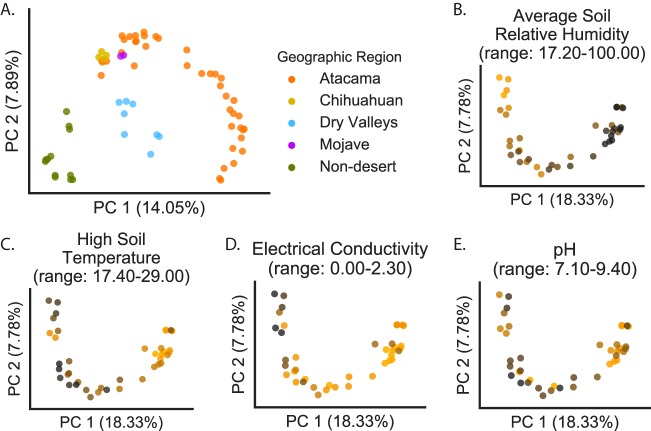
Unweighted UniFrac PCoA plots. (A) Combined data from the present Atacama Desert study and from Fierer et al. (19). (B to E) Atacama-only data. (A) Samples colored by their geographic origins. (B to F) Samples colored by soil properties, where light colors indicate the low end of the specified range and dark colors indicate the high end of the specified range. These data illustrate statistical results presented in Table S3, specifically, that average soil relative humidity is a better predictor of sample composition in the Atacama Desert than high soil temperature, electrical conductivity, or pH.